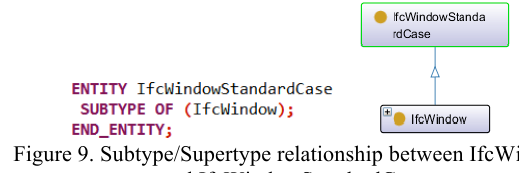
Figure 9. Subtype/Supertype relationship between IfcWindow and